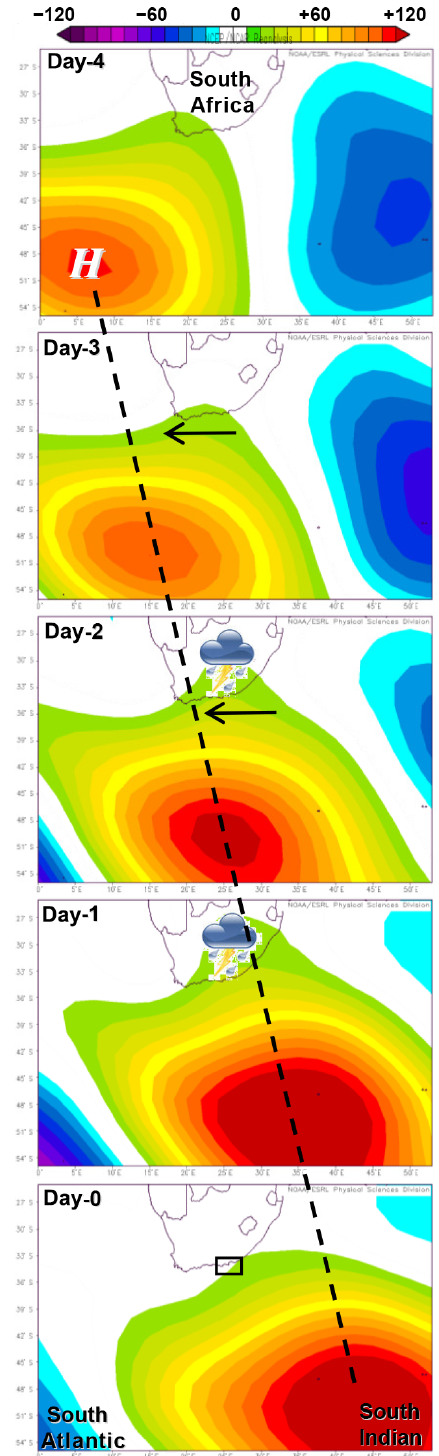
Figure 7. Composite 500hPa geopotential height anomalies (shaded) for the top-10 chlorophyll fluorescence events, (top down) from − 4d (before) to zero (color max), with dashed line fol- lowing the midlatitude ridge. Composite anomaly easterly winds (>10ms − 1 ) and heavy rainfall (>50mm) are represented by the arrow and icon, respectively; index area is shown by the black box in the lower panel.